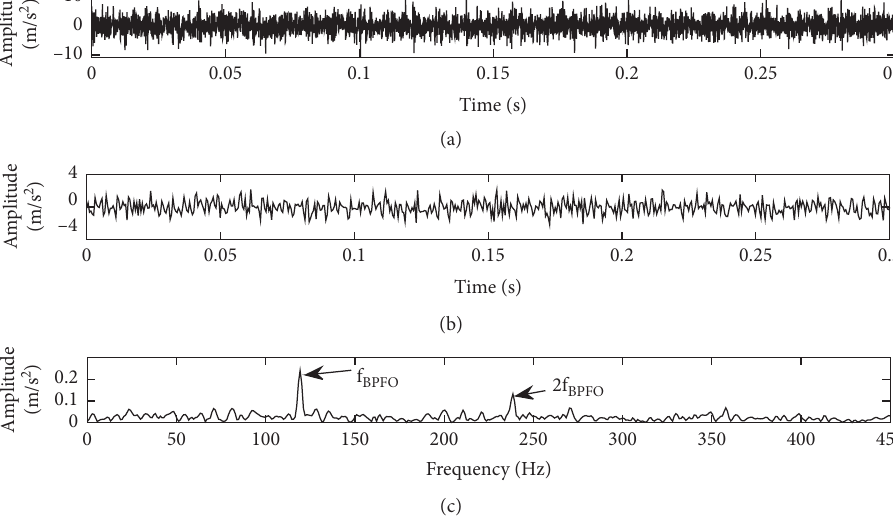
Figure 9: (a) The original simulation signal. (b) The signal filtered by fast kurtogram. (c) The square envelope for the